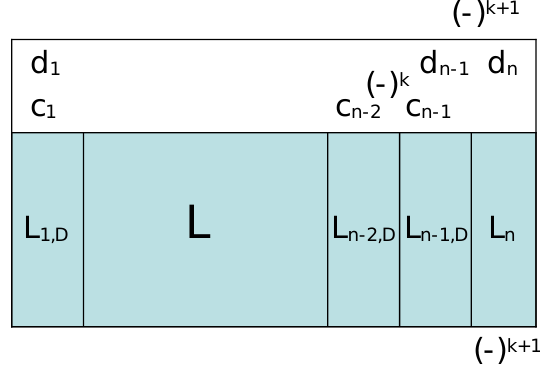
Figure 15 . Nontrivial boundary case j = n (cid:0) 2 for which column j +1 coincides with n (cid:0)